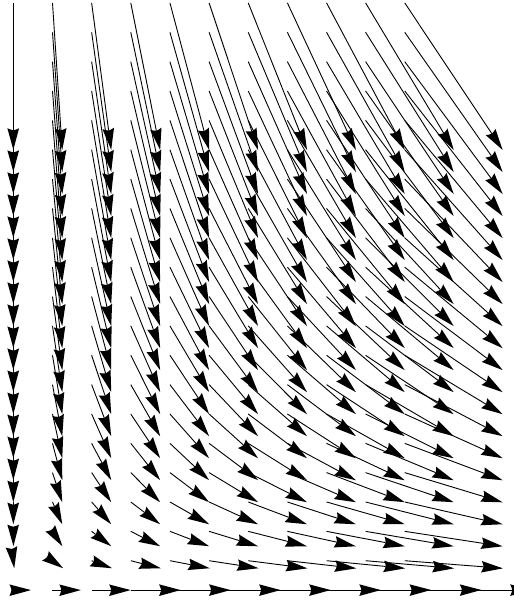
Figure 12: The vector field ( u , v ) from Eq. (4) for λ = 0.1 , S = −0.3 , for hydraulic oil at a temperature of 40 ◦ C .